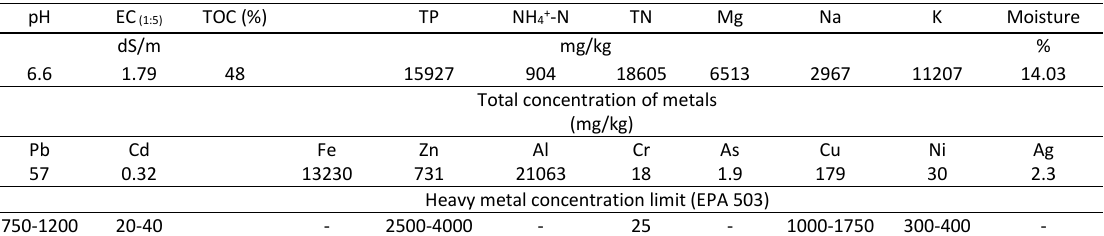
Table 2: Chemical properties of sewage sludge